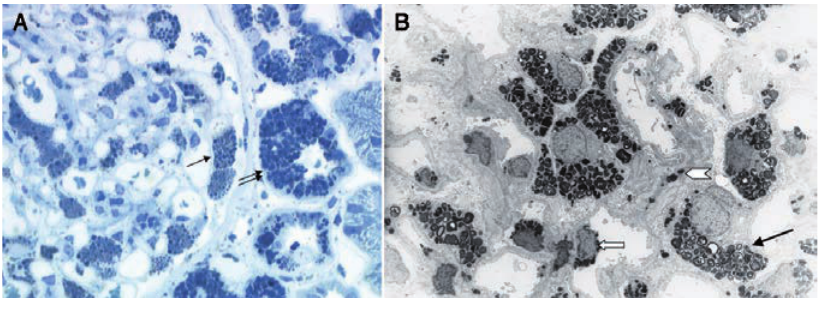
Figure 9. Evidence of Gb3 inclusions in the kidney. Panel A) sphingolipid inclusions in podocytes (arrow) and distal tubule epithelial cells (double arrow). Panel B) lysosomal inclusions in podocytes (arrow), endothelial (open arrow) and mesangial cells (open arrowhead) ( Reprinted with permission of the publisher from Tøndel et al. 64